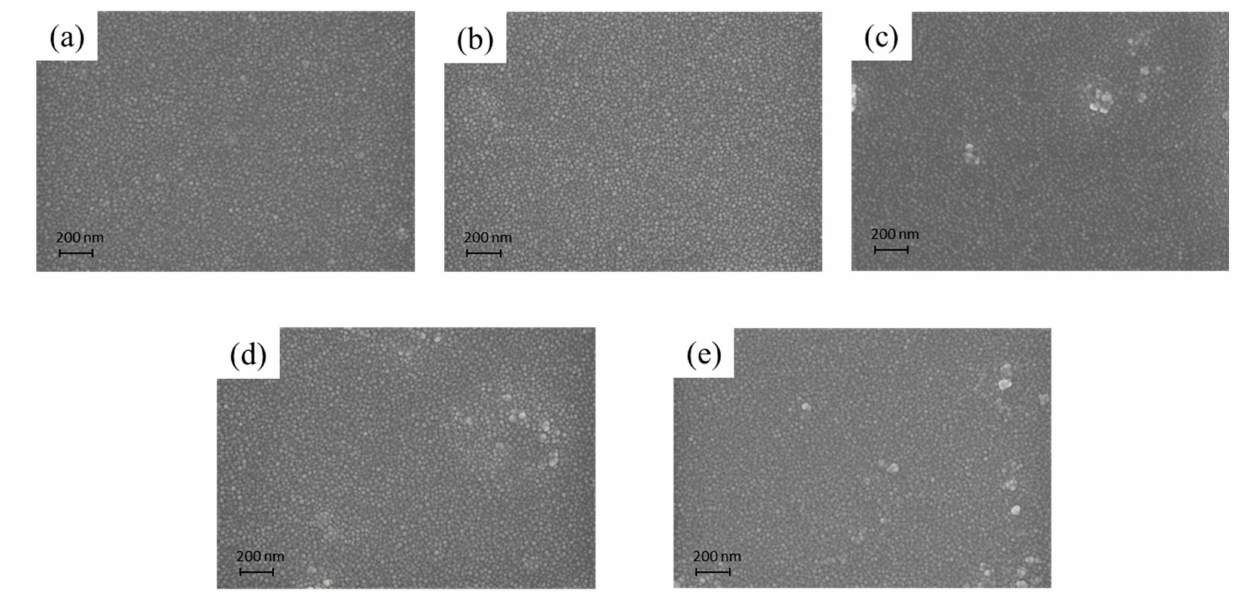
Figure 5. The scanning electron microscopy (SEM) analysis of the as-prepared nanohybrid silica polyacrylate film. ( a ) Without adding DFMA, ( b ) weight ratio of DFMA/MMA at 1:17, ( c ) weight ratio of DFMA/MMA at 1:8, ( d ) weight ratio of DFMA/MMA at 1:5, and ( e ) weight ratio of DFMA/MMA at 2:7.